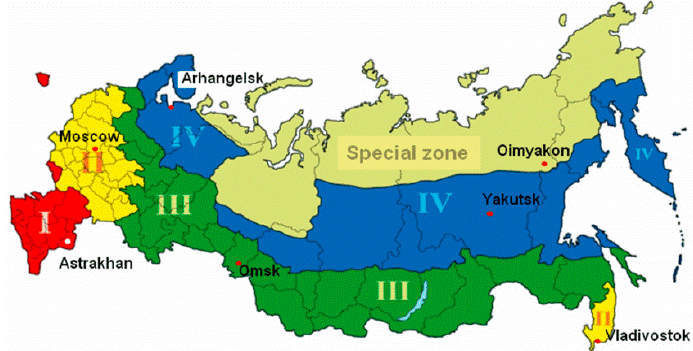
Figure 2. Climatic zones of the Russian Federation (RF) [44] selected for the present analysis.